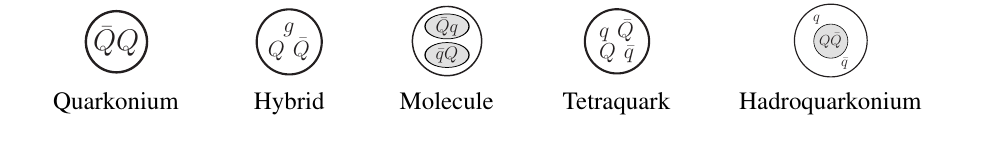
Figure 3. Models for the XYZ exotic